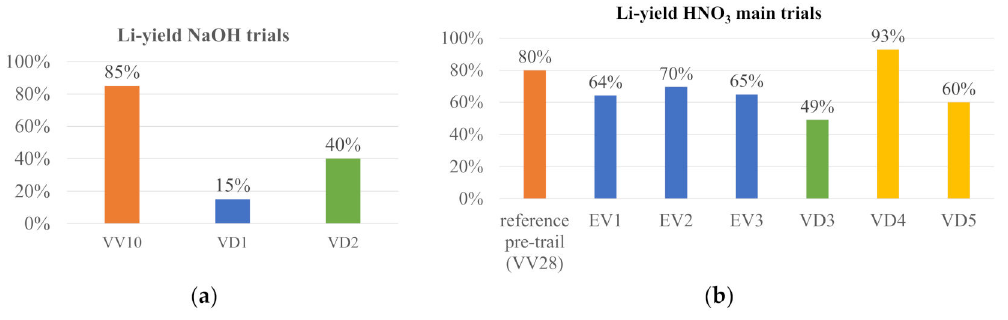
Figure 10. ( a ) Overview of the lithium yields reached in the pre-trial (VV10) and in the main trials (VD1 and VD2) by using NaOH as solvent. ( b ) Overview of the lithium yields reached in the best-case pre-trial (VV28) and the main trials (EV1-3, VD3-5) by using HNO 3 as solvent.